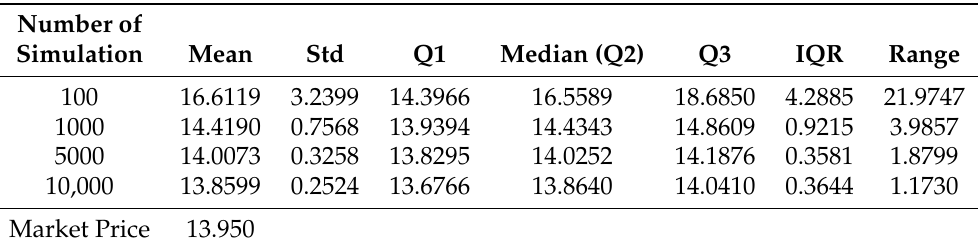
Table 8. Numerical Summary of the bootstrapping. We repeat the MCS pricing 100 times for various number of simulation, and calculate basic statistics for the 100 MCS put prices.